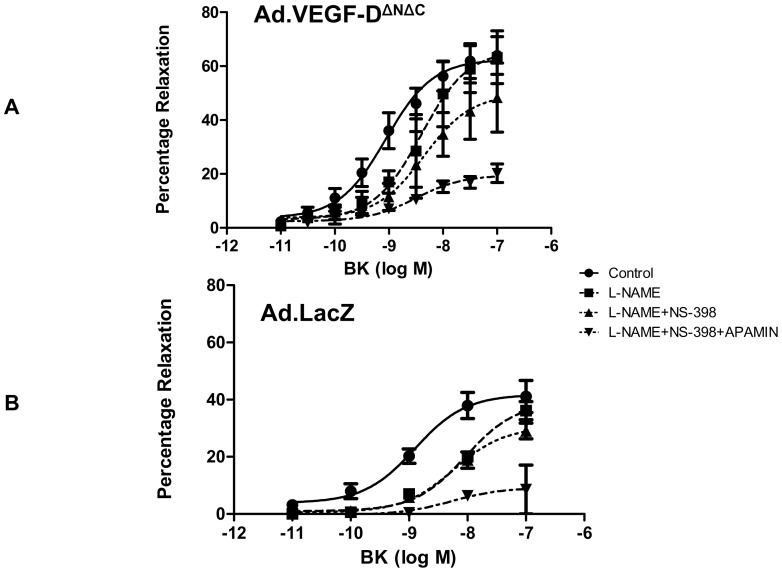
The endothelium-dependent relaxation to bradykinin in the presence of different inhibitors of the relaxation pathway in pregnant sheep uterine arteries, 4–7 days after Ad.VEGF-DΔNΔC or Ad.LacZ transduction.The contribution of NO, PGI2 and EDHF on the relaxation response to BK were investigated in vessels pre-contracted with PE. Cumulative relaxation curves of BK (10−11M to 10−6M) were constructed under the following conditions: (1) control (no inhibitors); (2) in the presence of L-NAME (300 µM); (3) in the presence of L-NAME and NS-398 (COX-2 inhibitor, 10 µM); (4) in the presence of L-NAME, NS-398 and apamin (1 µM). Relaxation was expressed as a percentage of inhibition of PE-induced contraction. The mean relaxation response of vessels from singleton pregnant sheep was calculated (n = 5). Statistical significance was assumed at p<0.05. The BK relaxant effect was reduced by L-NAME (p<0.05, n = 5), but not significantly modified by the further addition of NS-398. The remaining endothelium-dependent relaxation (Emax), that was resistant to NS-398 and NO synthase inhibition, was significantly reduced by pretreatment with apamin in both Ad.VEGF-DΔNΔC and Ad.LacZ treated arteries (P<0.05, n = 5). The residual relaxation that was resistant to the cumulative addition of all three inhibitors was significantly greater in the Ad.VEGF-DΔNΔC transduced segments compared to Ad.LacZ transduced segments.